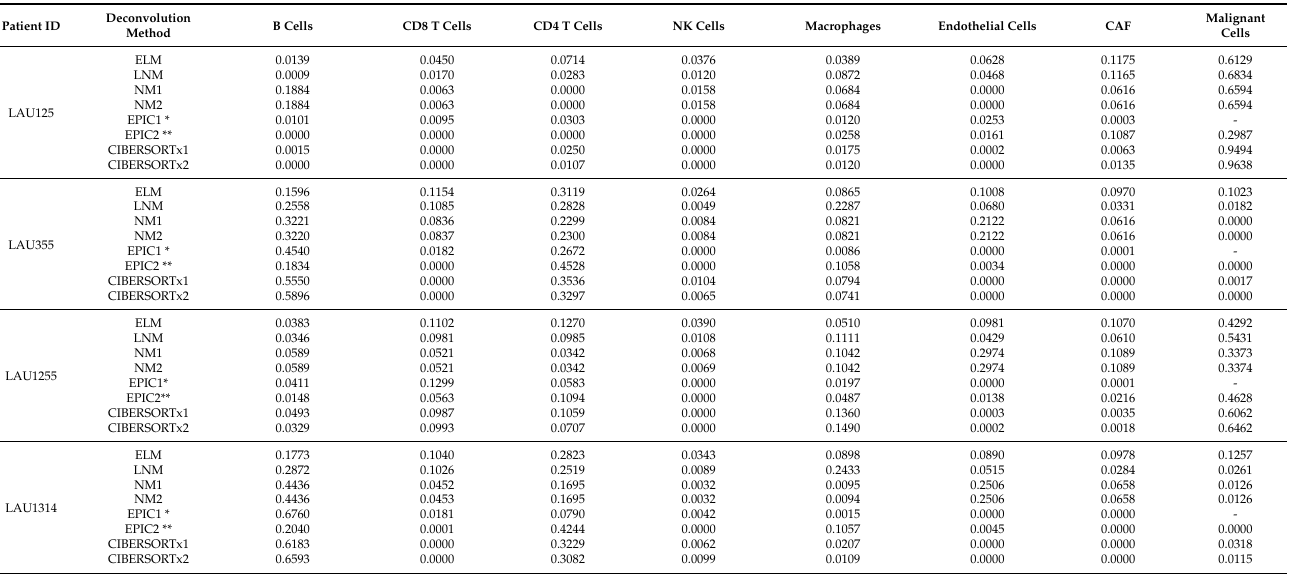
Table 3. Fractions of cell types estimated using deconvolution methods for the lymph nodes of metastatic melanoma